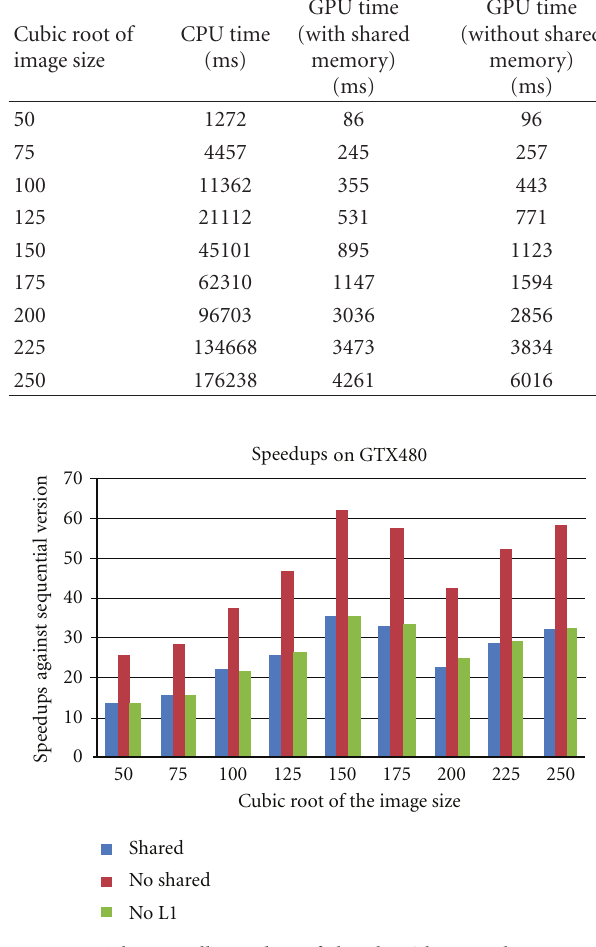
Figure 8: The overall speedup of the algorithm on the GTX480 system for di ff erent image sizes with the image size (with the data transfer times